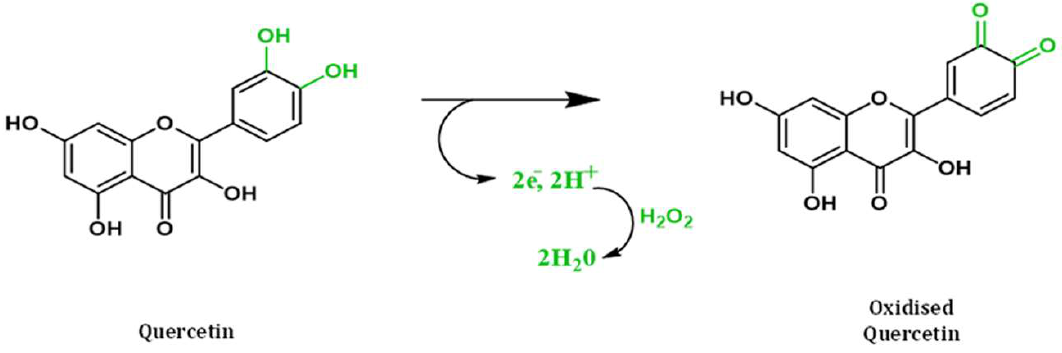
Figure 2. Mechanism of hydrogen radical scavenging activity of quercetin (flavonoid) present in TA extracts were reproduced with permission (73).